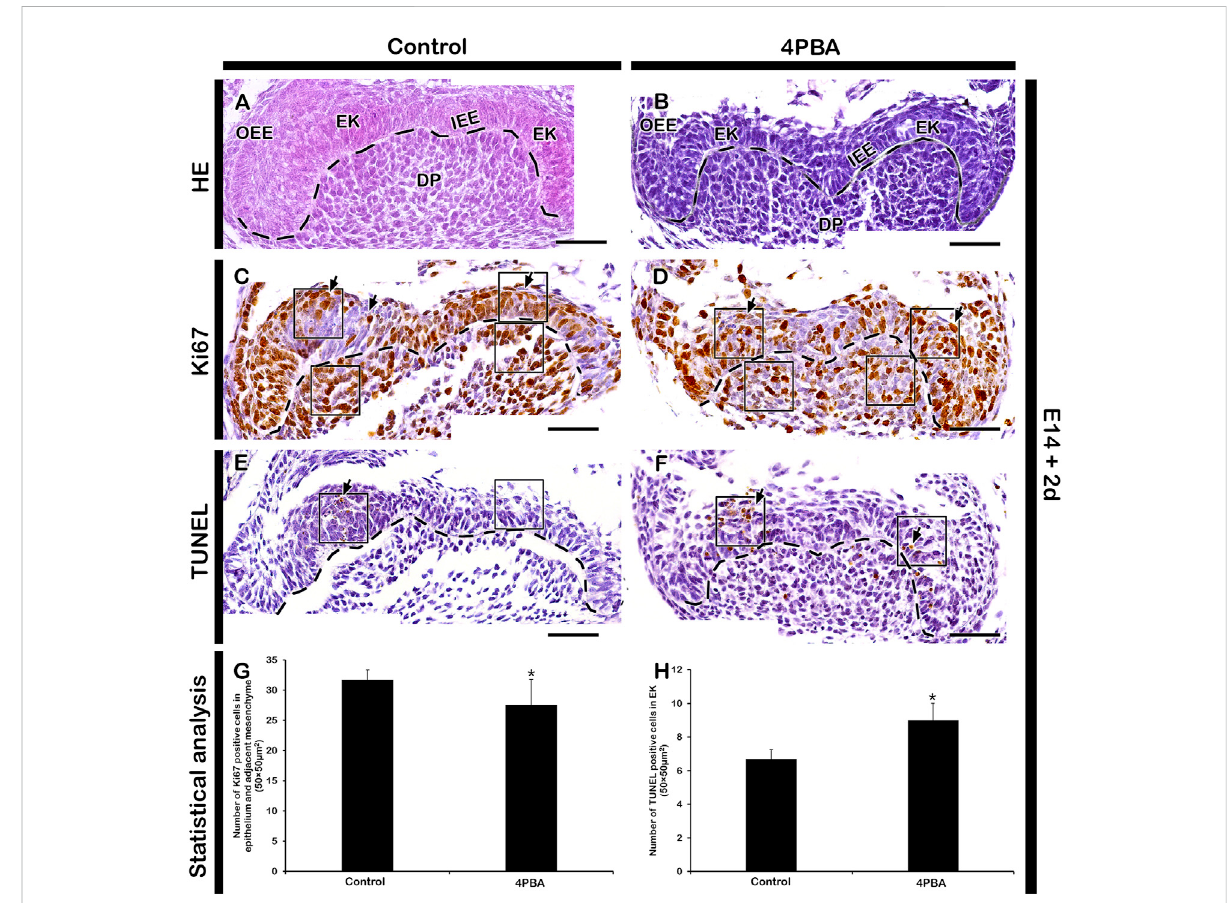
FIGURE 2 Histology, immunostaining of Ki67 and TUNEL assay of 2 days in vitro organ cultivated teeth. HE staining of in vitro cultivated teeth (A,B) . Ki67immunostaining (C,D) andTUNELassay (E,F) inthecontroland4PBAtreatedgroup.Inthe4PBAtreatedgroup, proliferating cellsarereducedin the epithelium and adjacent mesenchyme (C,D) , however, number of apoptotic cells are increased in epithelium when compared to control (E-F). Tissues are counterstained with hematoxylin (C – F) . Statistical analysis showing Ki67 and TUNEL positive cells (G,H) . N = 6. * indicates p < .05 (G,H) . Dotted lines demarcate the epithelial boundary (A – F) . Arrows indicate immunostaining and TUNEL positive cells (E,F) . Square boxes indicateareaof50 µm 2 ×50 µm 2 forpositivecellcount (E,F) .EK,enamelknot;SR,stellatereticulum;IEE,innerenamelepithelium;DP,dentalpapilla. Scale bars: 50 μ m (A – F)